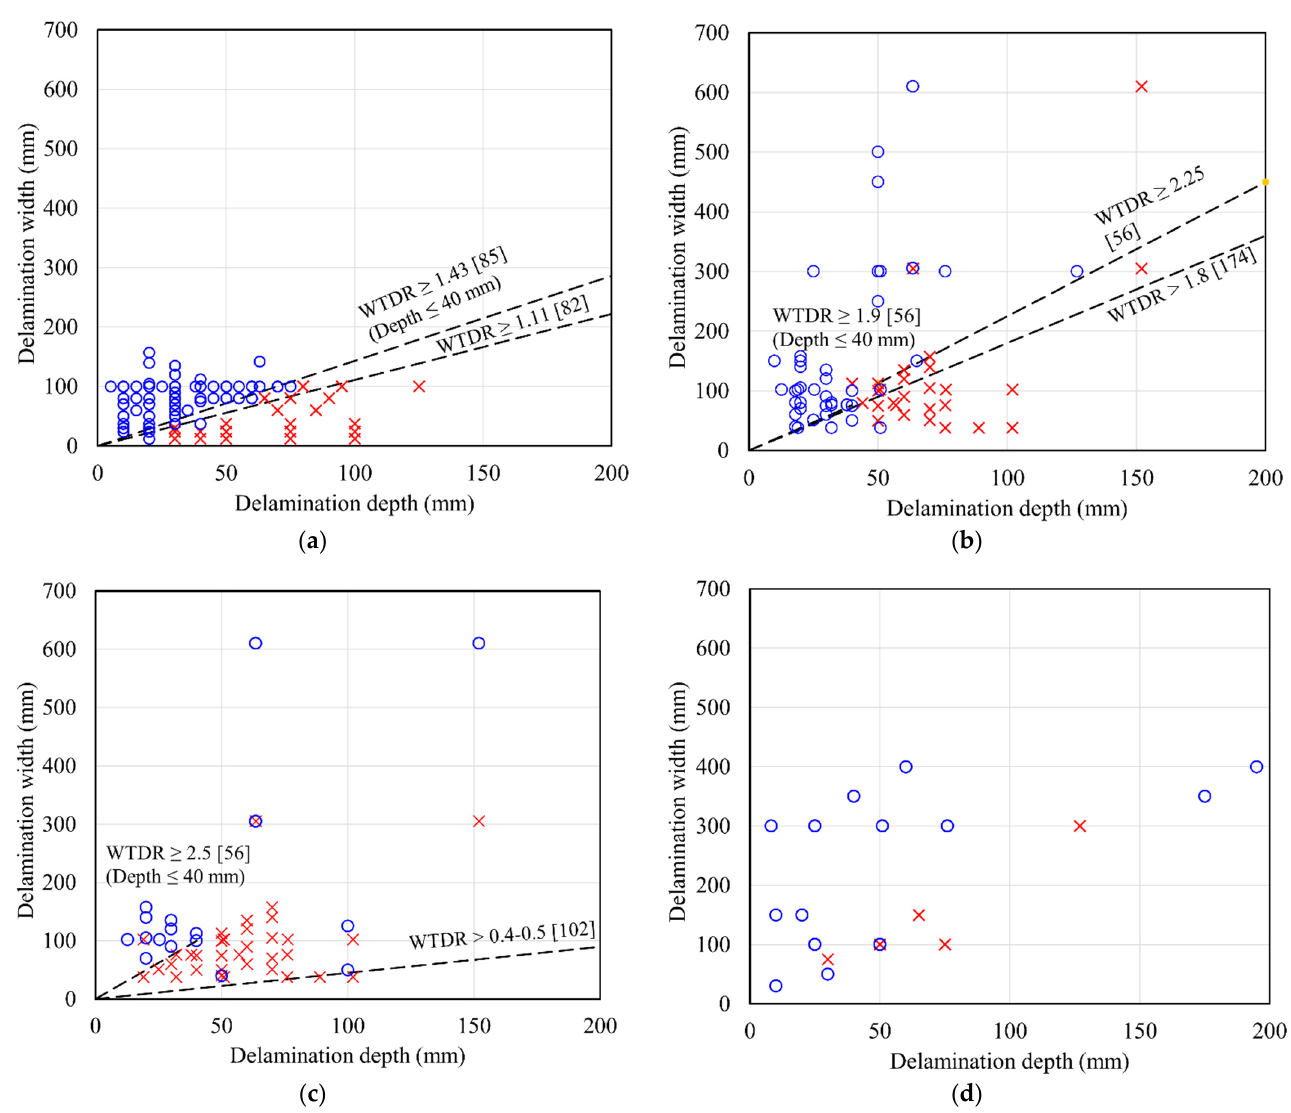
Figure 6. Synthesises of literature about detectability with respect to depth and size of delamination in concrete: ( a ) laboratory test; ( b ) outdoor test with solar irradiation measured during heating cycle (daytime); ( c ) outdoor test with solar irradiation measured during cooling cycle; ( d ) outdoor test in shaded areas. Legends are that blue circles indicate detectable delamination, while red crosses indicate undetectable delamination. Synthesized data have following terms: target object is ordinary concrete; analysis method is one-time data analysis; width represents diameter or shortest side of delamination; detectability is determined according to each study.